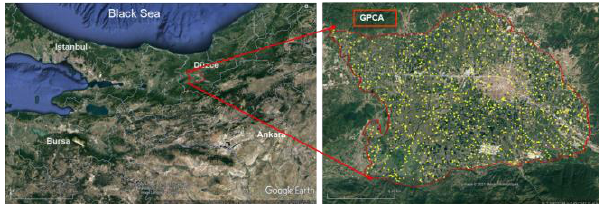
Figure 1 . Study area - the boundary of Düzce Great Plain Conservation area